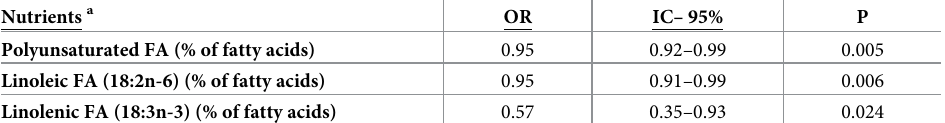
FA: fatty acid a Each nutrient was separately analyzed in models adjusted for gender, smoking, cardiovascular disease, use of Renin Angiotensin Aldosterone System agents, systolic blood pressure, fasting plasma glucose, HDL cholesterol and total energy